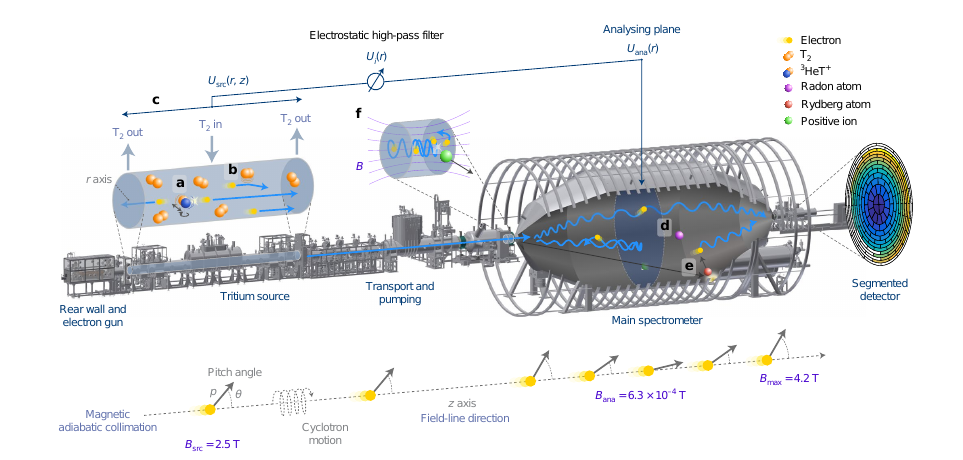
Figure 2. Illustration of the KATRIN beamline [8]. The 70-m-long beamline is composed of a rear wall section, a tritium source, a transport and pumping section, a pre- and a main spectrometer and a segmented focal plane